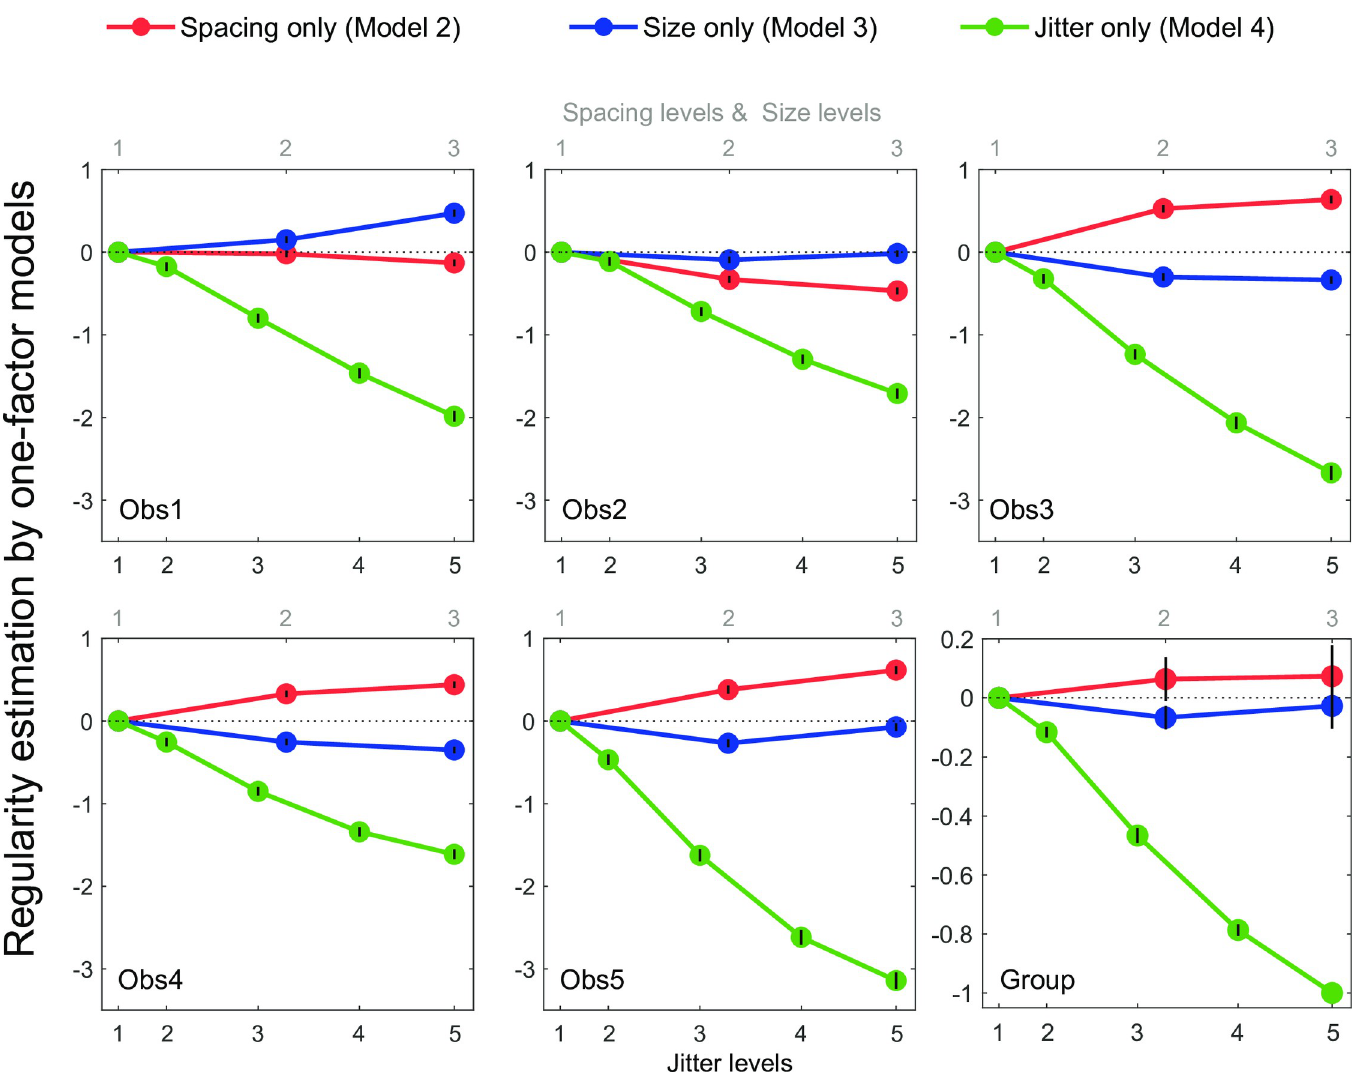
Fig 4. Parameter estimates of the one-factor statistical models for each observer and their normalized group mean. The estimated values are plotted as a function of element spacing level (red lines), element size level (blue lines), and jitter level (green lines). The three element spacing and element size levels correspond to the top scale in the abscissa, while the five jitter levels are indicated by the bottom scale in the abscissa, which correspond to the proportion of the averaged Pythagorean distance of the resulting element positions (see S7 Fig). For the individual graphs (Obs 1–5) the error bars represent standard errors of the parameter estimation from second partial derivatives of the log likelihood at the minimum [17]. For the group graph, the original parameters were normalized to the maximum absolute value, which is condition R γ 5 , for each observer, then averaged across observers. The error bars represent standard errors of the normalized parameters calculated across the five observers. No error bars for conditions R α 1 , R β 1 and R γ 1 as they were set to 0 at each individual’s level. Also no error bar is shown for condition R γ 5 in group plot as it was set to -1 for